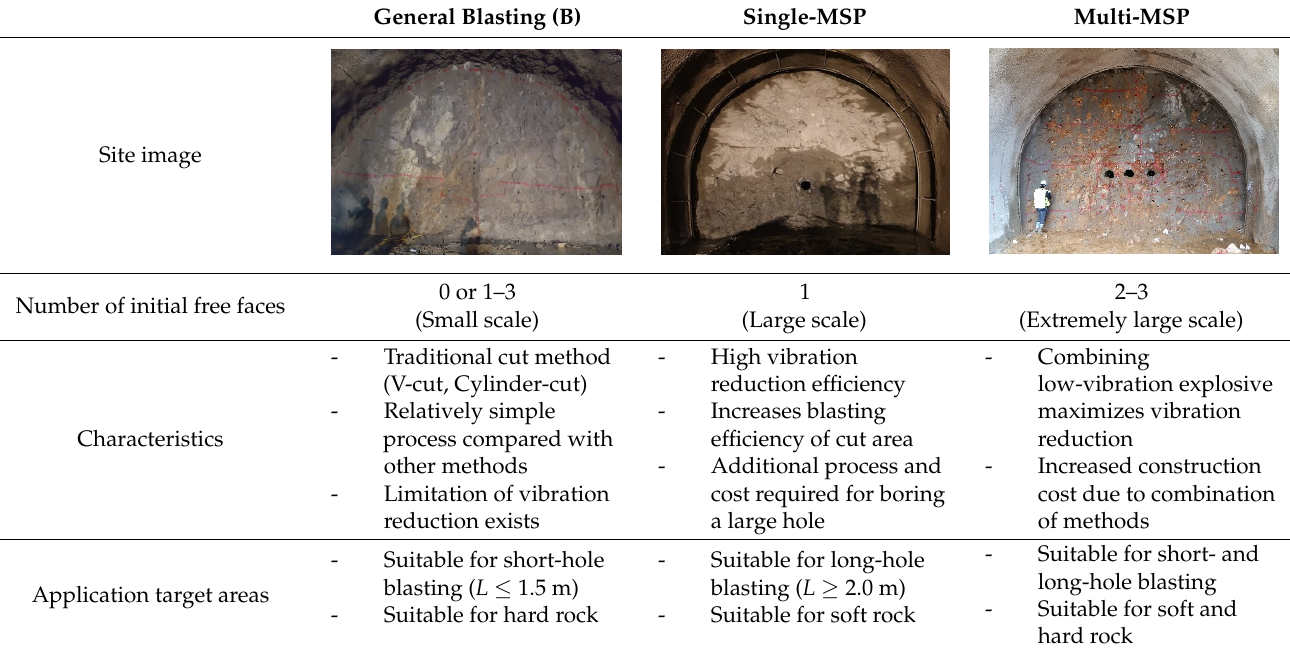
Figure 3. Field applications of MSP method: ( a ) horizontal tunnel for blasting, ( b ) horizontal tunnel for non-vibration excavation, and ( c ) vertical shaft for blasting.